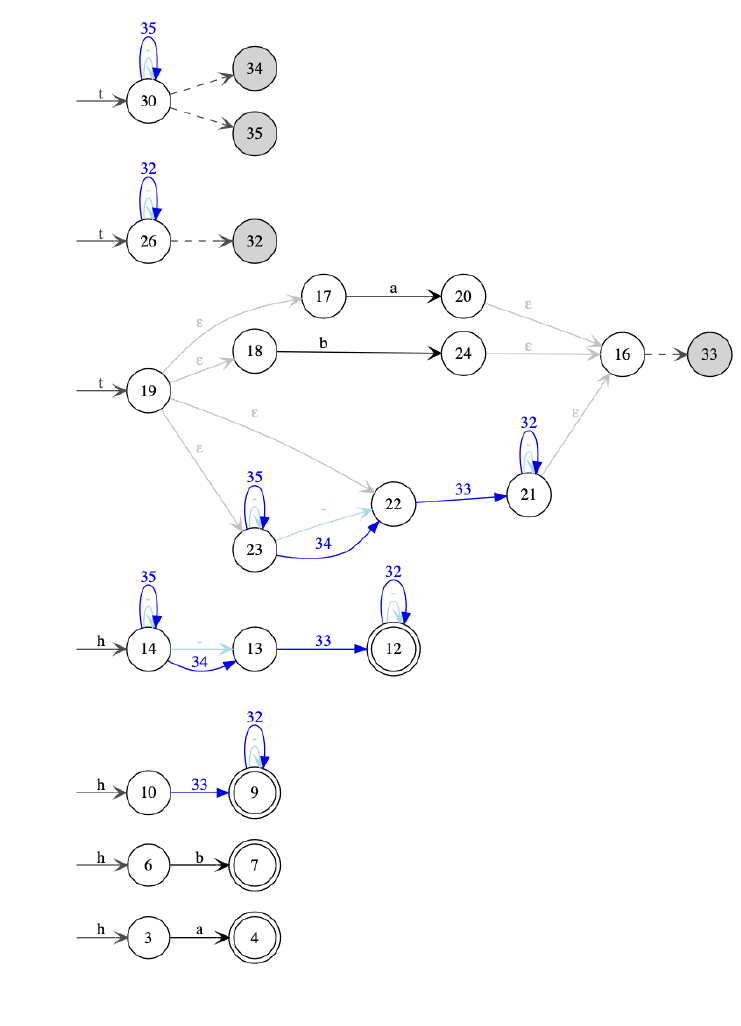
Figure A3. Stepwise hedge automaton from NWA for step ( nwa ( ch ∗ ( a + b )))